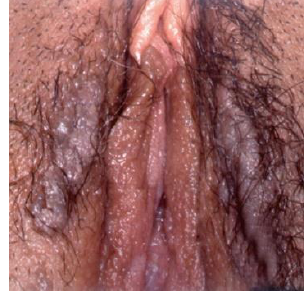
Figure 13. Vulvar HSIL.